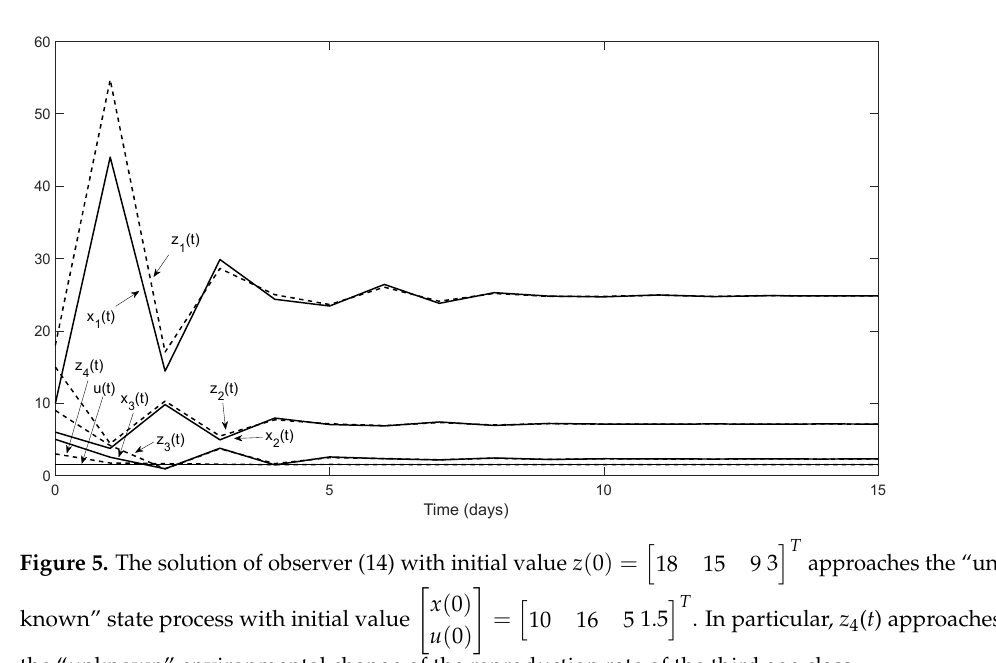
[ ] (cid:104) (cid:105) T T z 3 91518)0( = approaches the “un- approaches the 18 15 9 3 (cid:34) (cid:35) )0(   . In particular, z (cid:104) (cid:105) T x ( 0 ) = 4 ( t ) approaches = . In particular, z 4 ( t ) approaches 10 16 5 1.5   )0( u ( 0 )